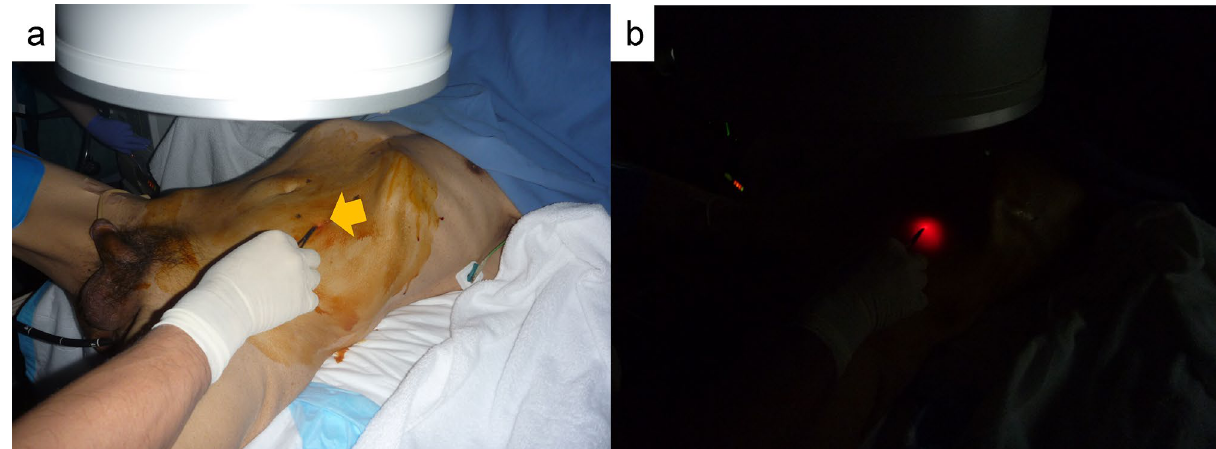
Figure 2. Identification of the site for puncture using ( a ) the finger pressing test (which involves pressing down the abdominal wall with a finger or Pean forceps under fluoroscopy) and ( b ) the illumination test to confirm that the sigmoid-descending colon (SD) junction is directly below the target site of